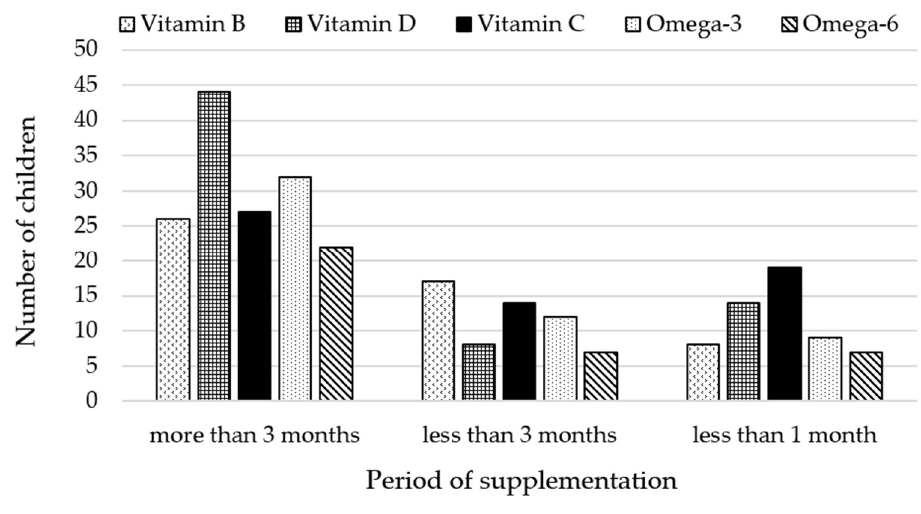
Figure 5. Number of children supplemented over a given period.